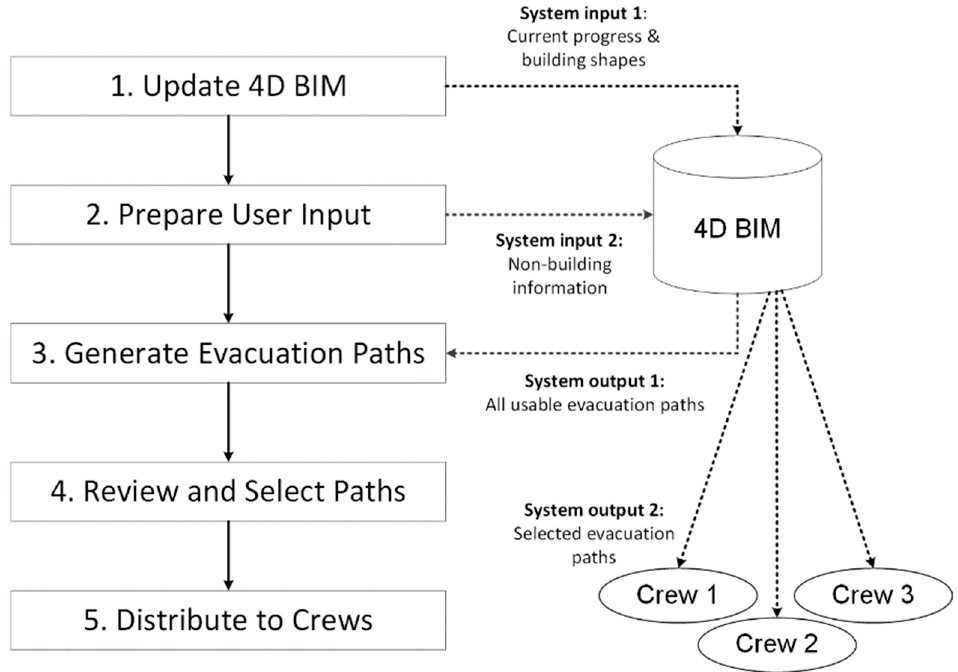
Figure 1. Framework for evacuation path planning in 4D BIM.